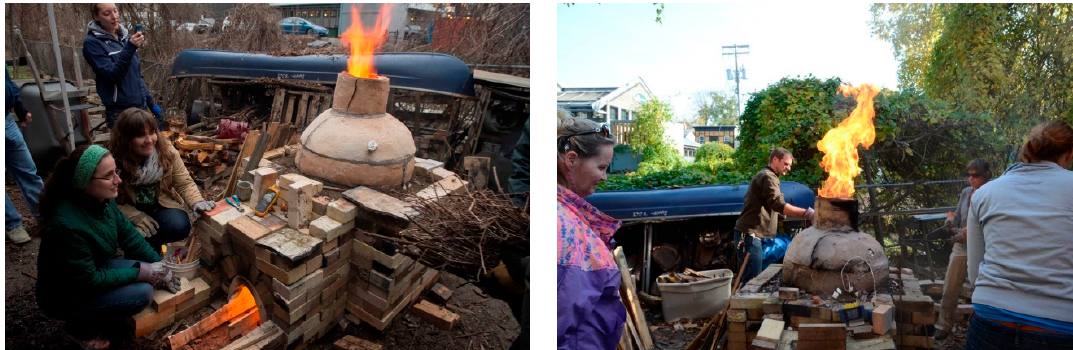
Figure 10. The eruption and persistence of a bright orange flame from the chimney in the oxidation phase.